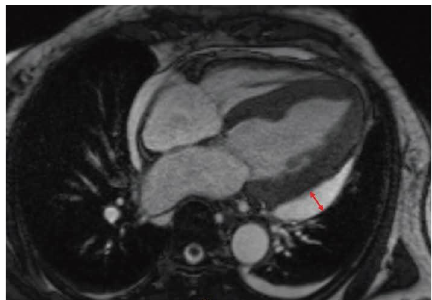
Figure 6: Cardiac MRI 10 days after initial presentation. Axial image captured in mid-diastole shows moderate pericardial efu- sion (red line) without pericardial or pleural